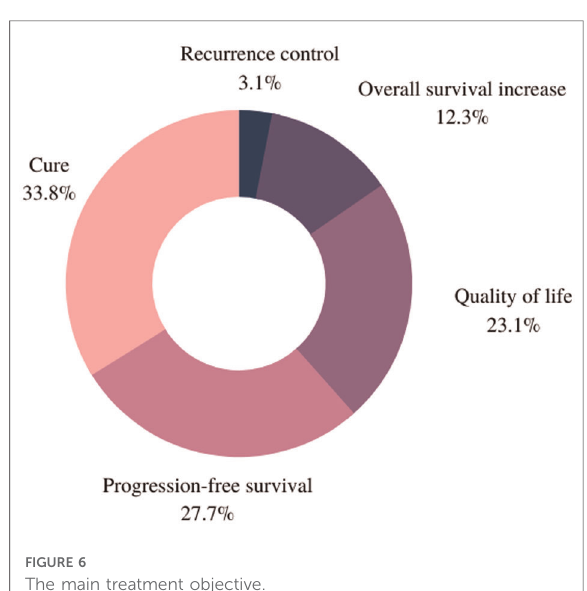
FIGURE 6 The main treatment